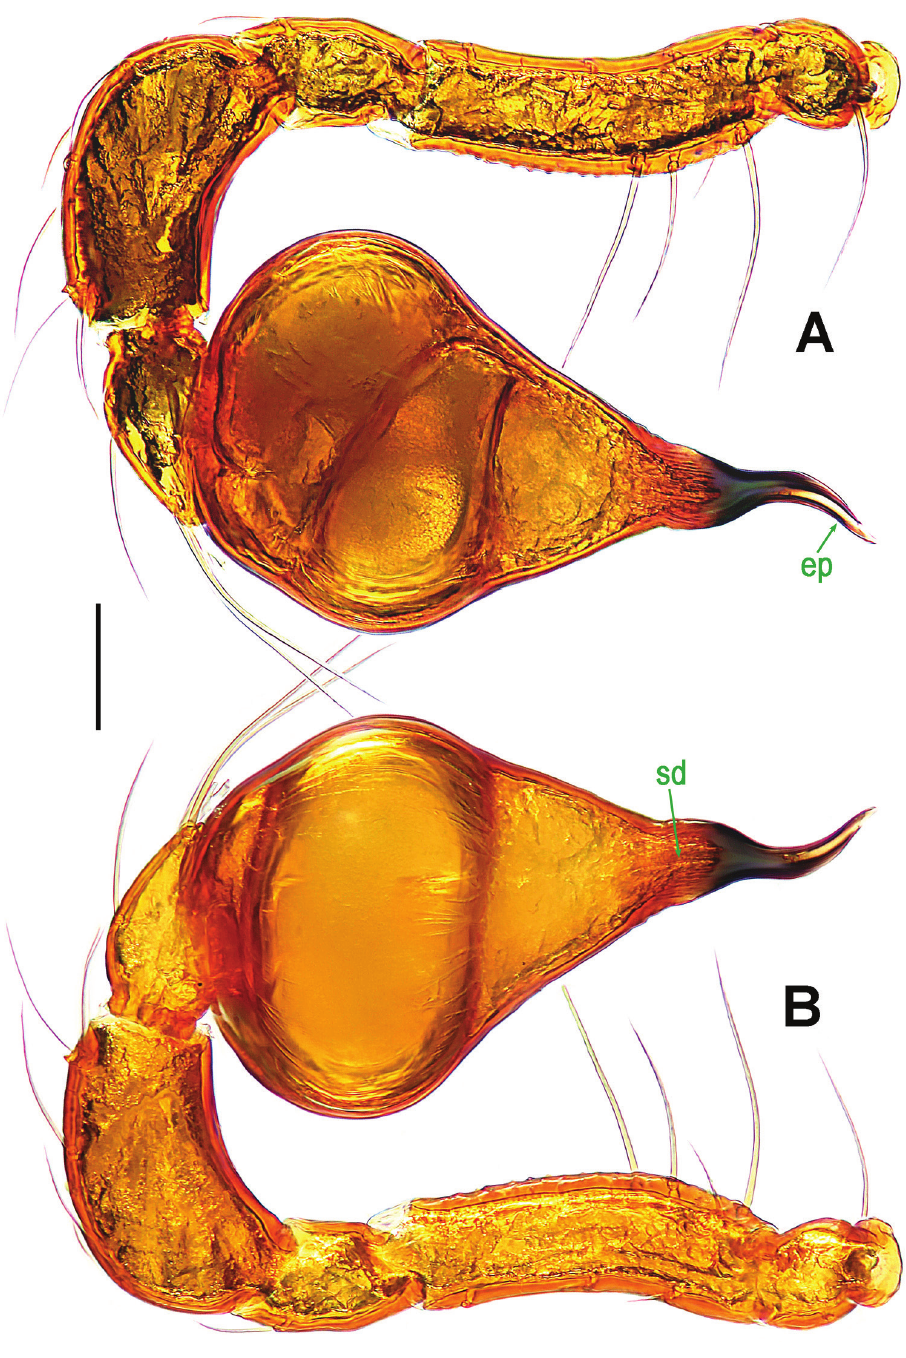
Figure 14. Brignoliella michaeli Lehtinen, 1981, male from Singapore. A left palp, retrolateral B ditto , pro- lateral. Abbreviations: ep = embolic part of apes of palpal organ; sd = spermatic duct. Scale bars: 0.10